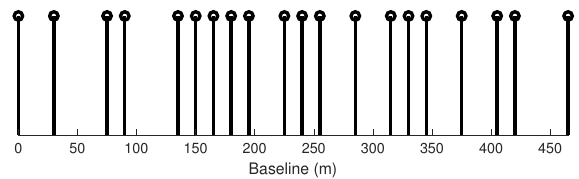
Figure 4. Baselines distribution in simulation